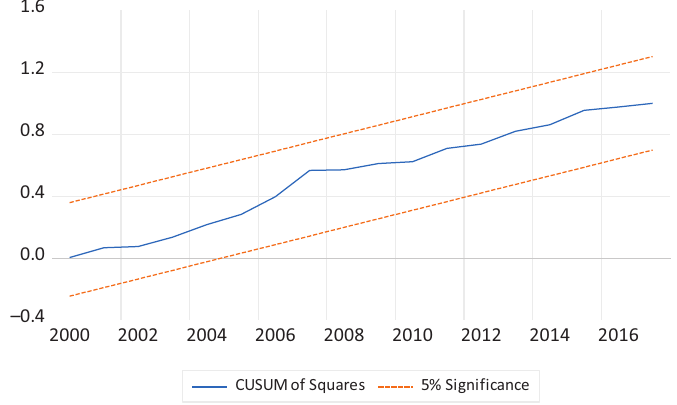
Figure 1. Plot of the cumulative sum of recursive residuals